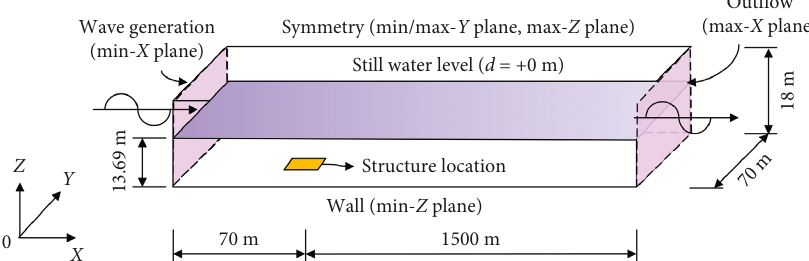
Figure 6: Numerical modeling of the wave field in Flow-3D. Table 4: Wave properties for numerical modeling.